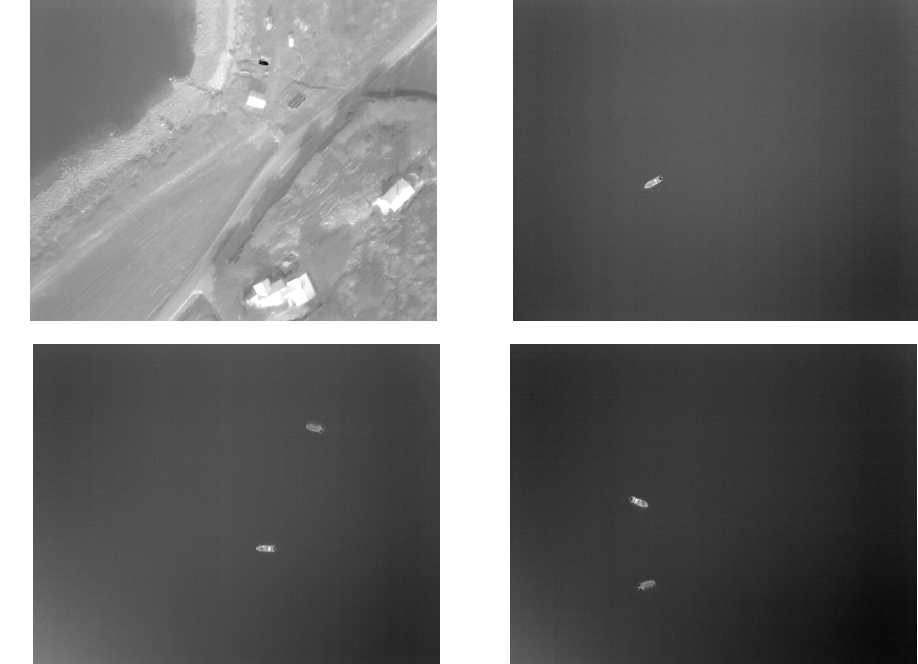
Figure 17. Infrared images captured during the